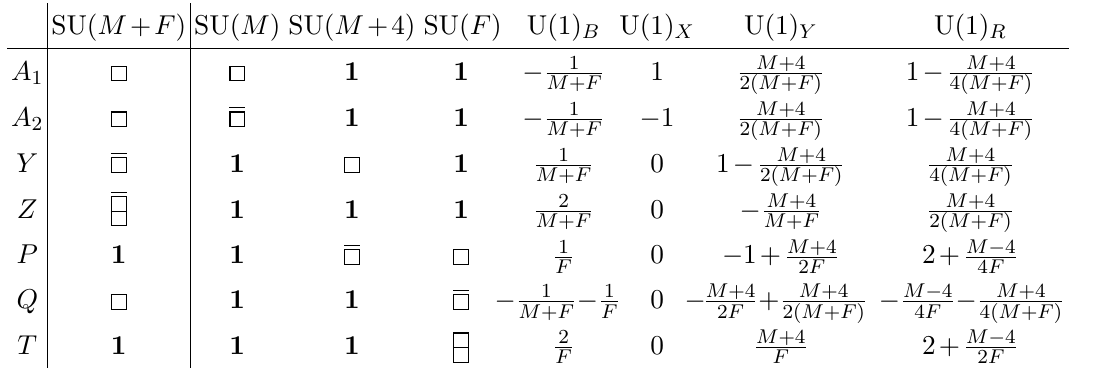
= U(1) R + y M U(1) Y + R +9 My 2 − 3(3 M +4) y M − M = 0 , M M